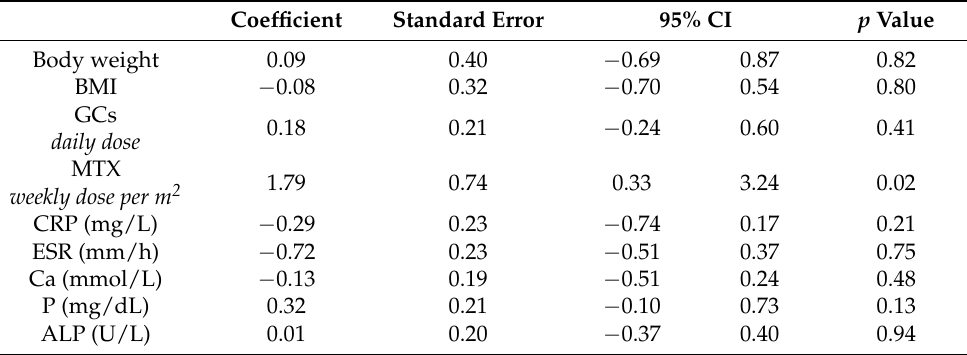
Table 4. Results of multinomial logistic regression performed to investigate multivariate analysis of factors associated with 25(OH)D